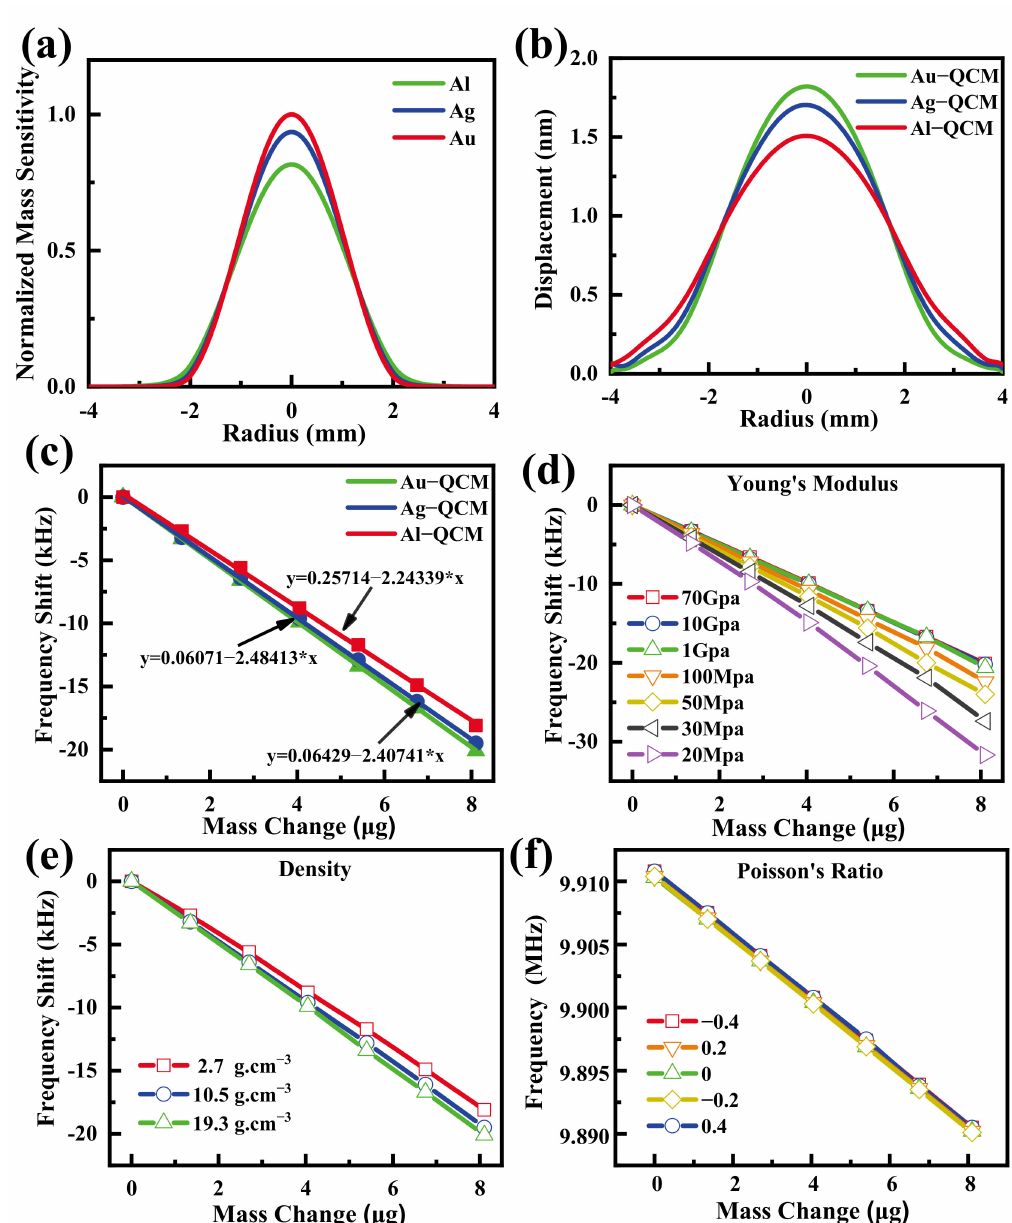
Figure 9. ( a ) The theoretical normalized mass sensitivity, the finite element analysis results of the ( b ) displacement, and ( c ) sensitivity of QCMs with gold, silver, and aluminum electrodes. Finite element analysis of mass sensitivity results at different values of ( d ) Young’s modulus, ( e ) density, and ( f ) Poisson’s ratio